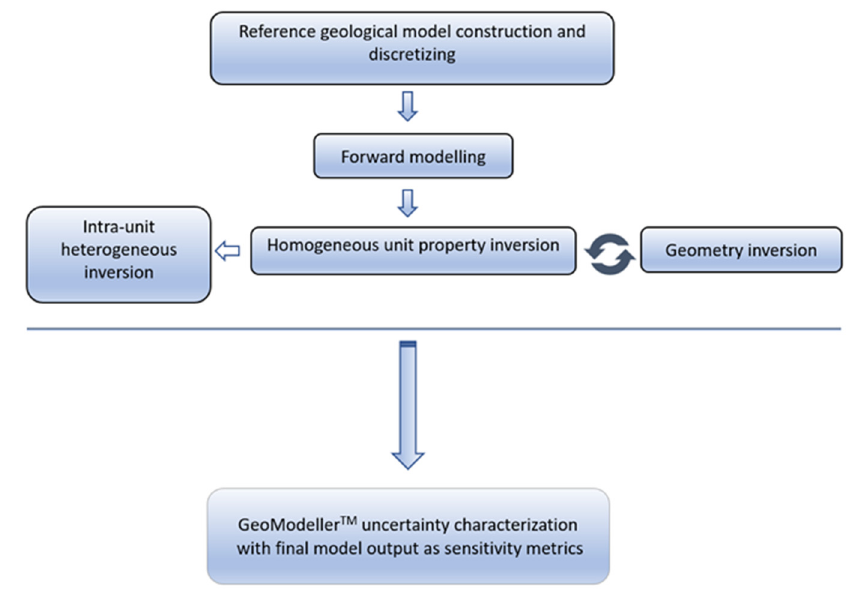
Figure 3. Flow chart of the applied methodology for 3D model generation and sensitivity characteri- zation. Intra-unit heterogeneous inversion (GoCAD TM ) was used specifically for the Rosebery–Lyell 3D model to generate rock property statistics on mafic–ultramafic complexes, which were used to inform follow-up modeling efforts.